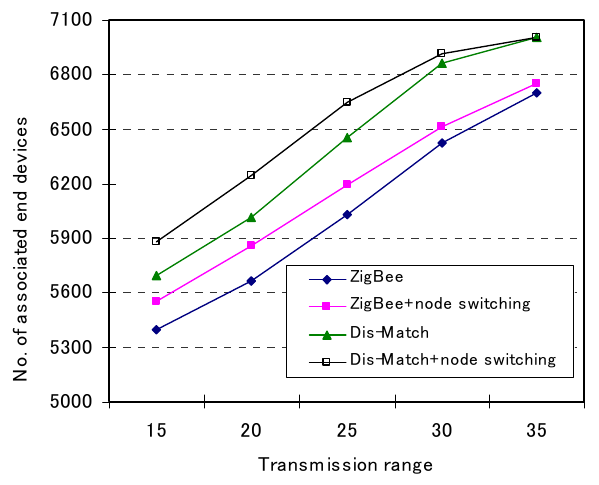
Figure 11. Number of associated end devices over transmission